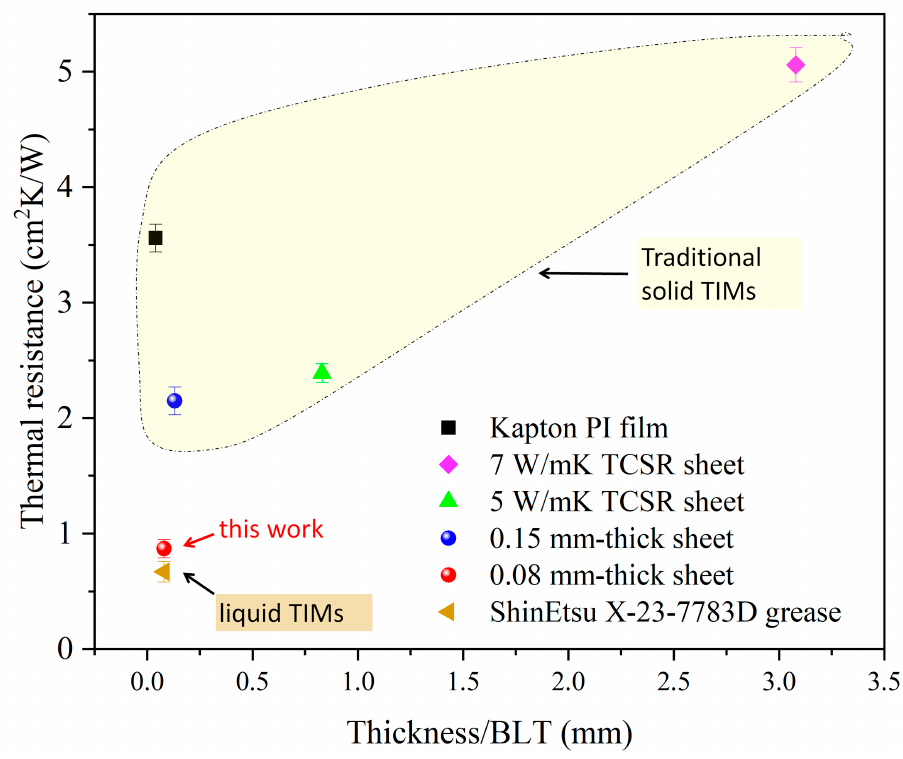
Figure 4. Scatter plots of the thermal resistance of typical electrically insulated TIMs against their thickness or BLT. The thickness and BLT here are the actual thickness during the thermal resistance tests. The 0.08 mm-thick TCSR-based sheet prepared by the low-viscosity calendering method